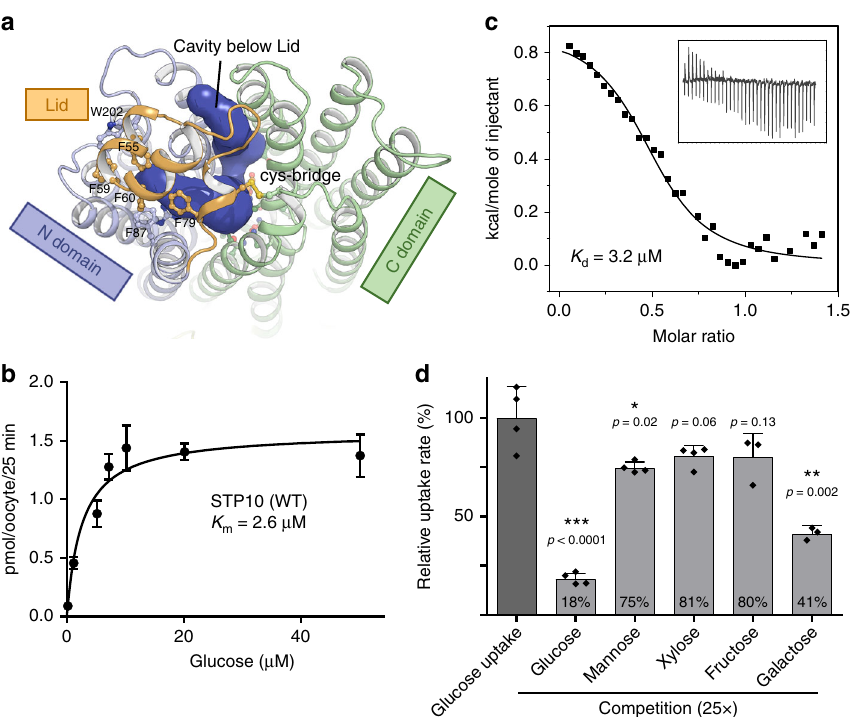
Fig. 2 Functional characterization of STP10. a Glucose access from the extracellular side is blocked by the Lid domain covalently linked to the C domain. b Michaelis-Menten fi t to glucose titration of STP10 using a Xenopus oocyte uptake assay at pH 5.0. c Binding af fi nity between glucose and STP10 by Isothermal titration calorimetry at pH 5.5. d Substrate speci fi city determined by competition in a yeast uptake assay at pH 5.0. * P < = 0.05; ** P < = 0.01; and *** P < = 0.001 by Student ’ s t test. Data for all assays are mean ± SD of three or more replicate